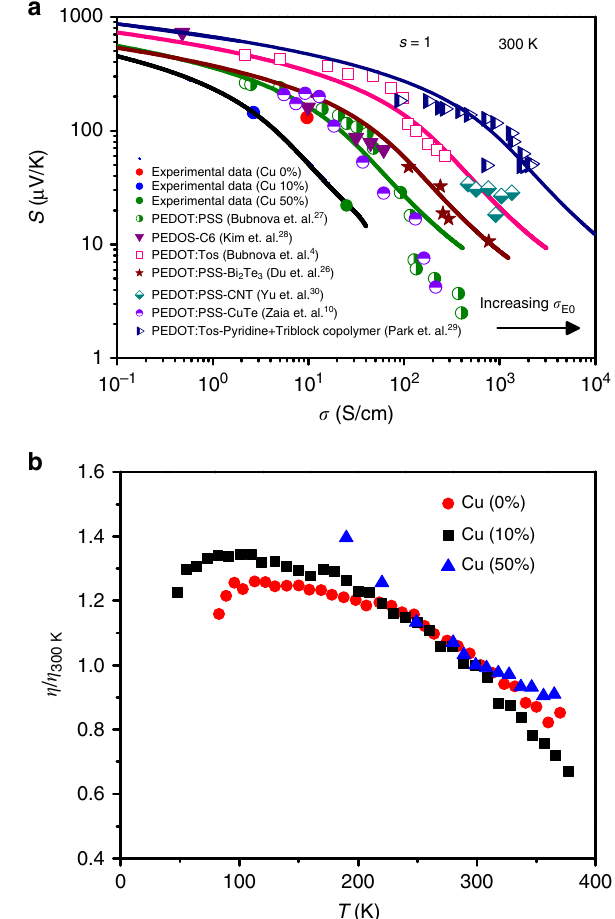
Fig. 4 Kang-Snyder transport model applied to various PEDOT based composites. a Experimental data of Seebeck (S) vs conductiviy ( σ ) for PEDOT:PSS (half closed green triangles) 27 , PEDOS-C6 (closed triangles) 28 , PEDOT:Tos (open squares) 4 , PEDOT:PSS-Bi 2 Te 3 (closed triangles) 26 , PEDOT:PSS-CNT 30 (half closed spades), PEDOT:PSS-Te(Cu x ) NW hybrid system (half closed circles) 10 and PEDOT:Tos-Pyridine (half closed triangles) 29 modeled with s = 1(solid lines). It is seen that, irrespective of the dopant counter-ion used, all hybrid PEDOT-based systems lies on s = 1 curve with different σ transport coef fi cient values, indicating that energy- E 0 dependent scattering is not changing in these organic-inorganic hybrid fi lms. b Reduced chemical potential, η = (E F -E t /k B T) of the PEDOT:PSS-Te (Cu x ) system plotted as a function of temperature for 0% (red closed circle), 10% (black closed squares) and 50 % Cu (closed blue triangles) samples, respectively. In line with expectations from the Kang-Snyder model, the reduced chemical potential only changes < 30% over a large temperature range in the samples and the change does not depend upon the Cu loading. The data is normalized with respect to the doping level at 300 K ( η 300K )